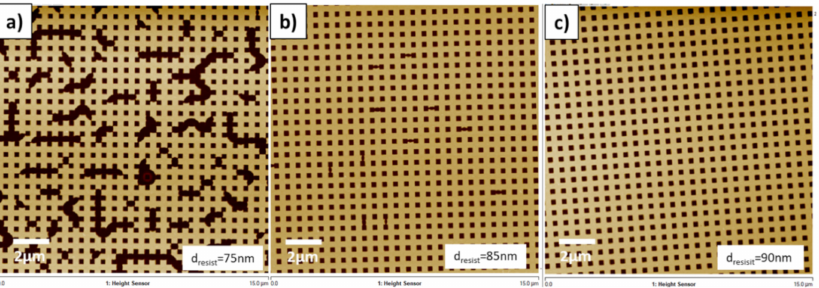
Figure 5. AFM images of the imprinted crossbar pattern using different resist layer thickness: ( a ) Fully replicated pattern with enough resist volume (d resist = 90 nm), ( b ) Imprint wits slightly less resist volume showing minor defects (d resist = 85 nm), and ( c ) Imprint with too less resist volume showing significant defects (d resist = 75